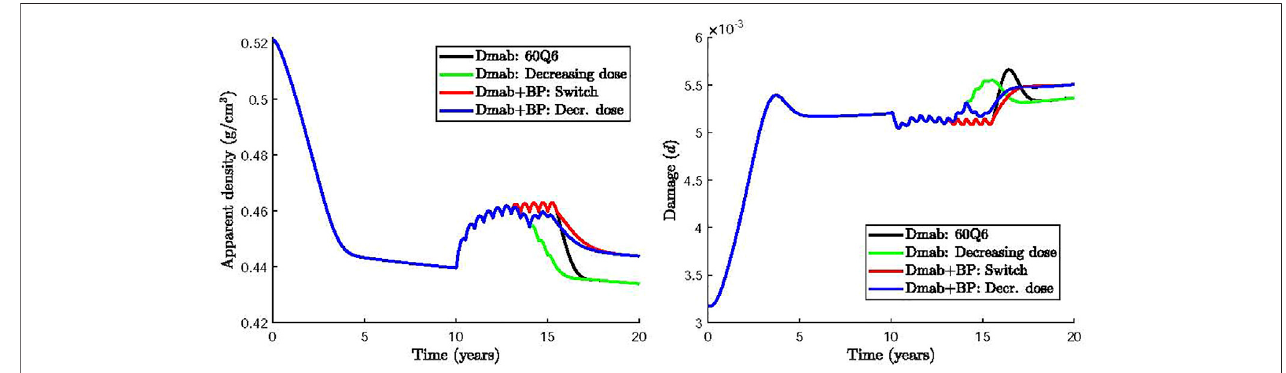
FIGURE7| EffectofDmabdiscontinuationstrategiesonboneapparentdensityanddamage:1)60Q6Dmabtreatment discontinuedafter5 years(black),2)60Q6 Dmab treatmentwitha decreasing dose (50, 40, 30, 20and 10 mg) for the last 5injections (green), 3) 60Q6Dmab treatment switched to BPafter 5 years (red), 4) 60Q6 Dmab treatment with a decreasing dose (50, 40, 30, 20 and 10 mg) for the last 5 injections and combined with BP from dose 30 mg onwards